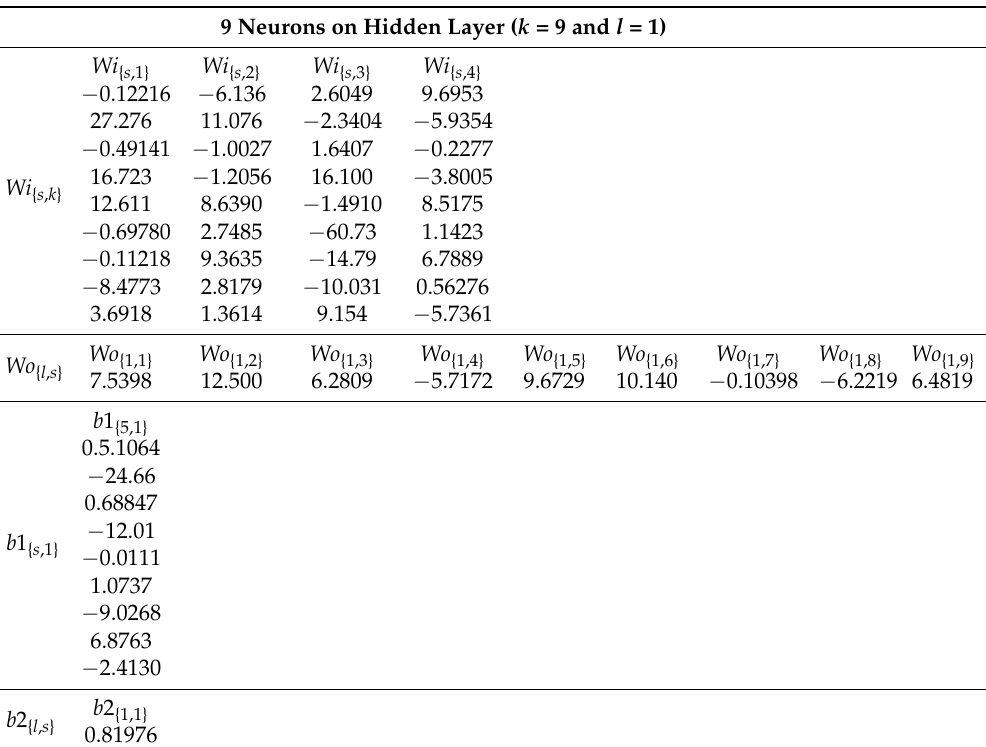
Table A3. Weights and biases for the ANN model predicting resistin